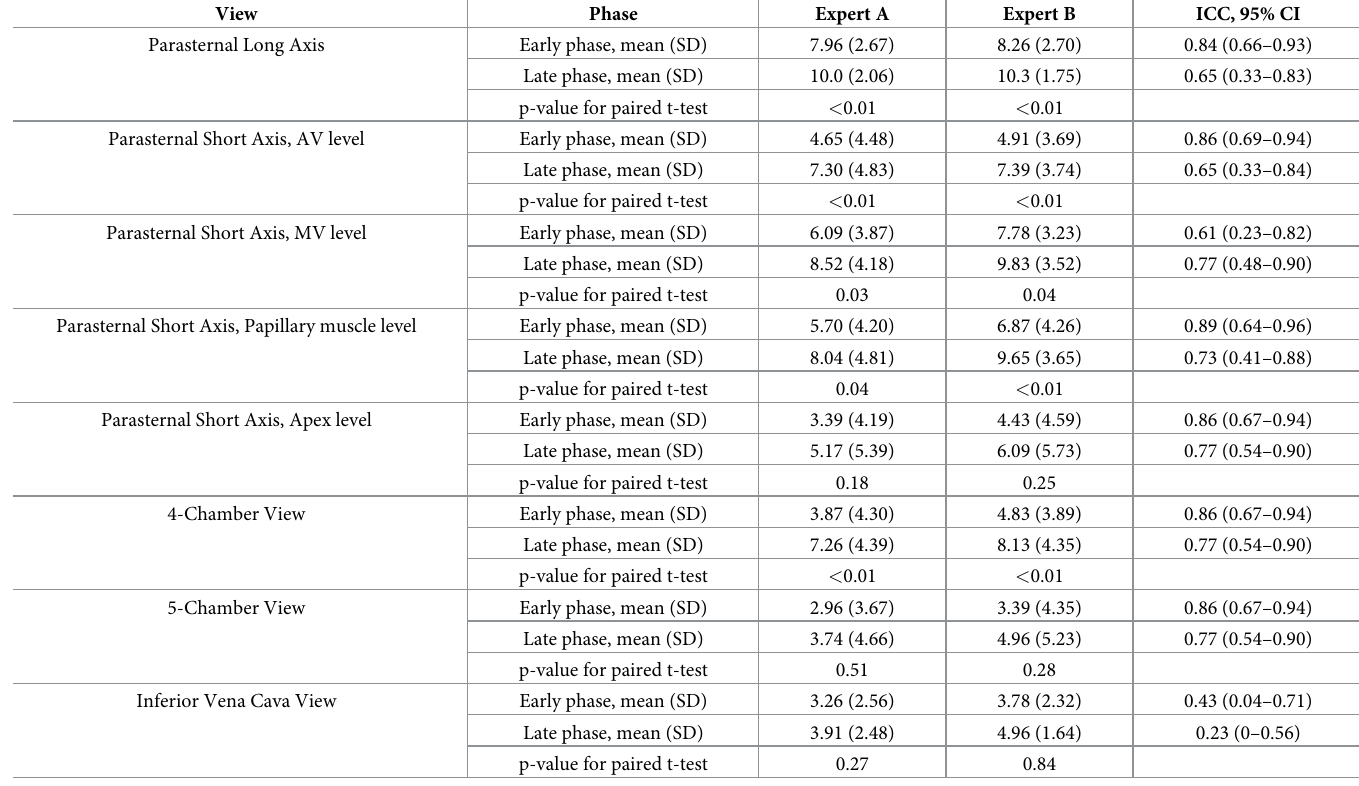
Table 5. Sensitivity analysis for cardiac ultrasound performance evaluation.